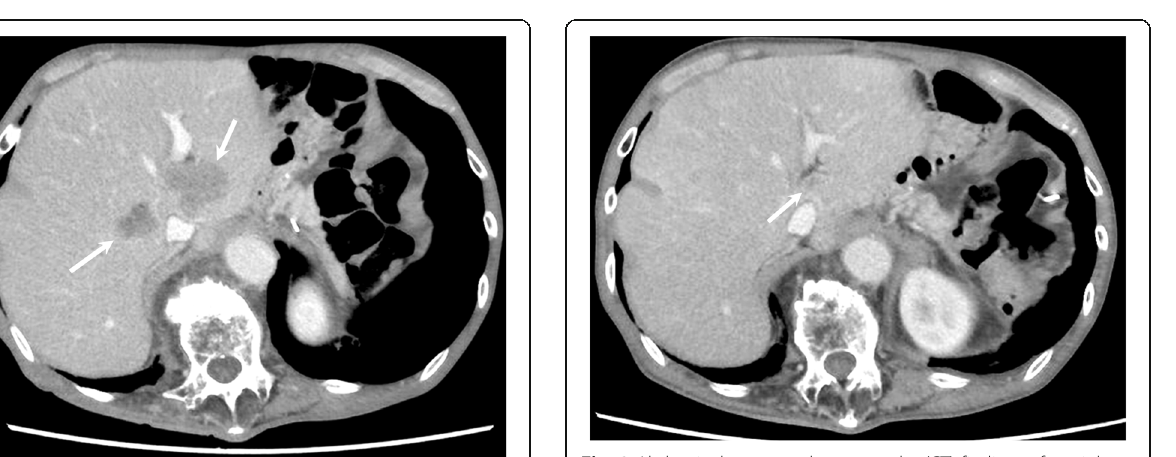
Fig. 3 Abdominal computed tomography (CT) findings after eight